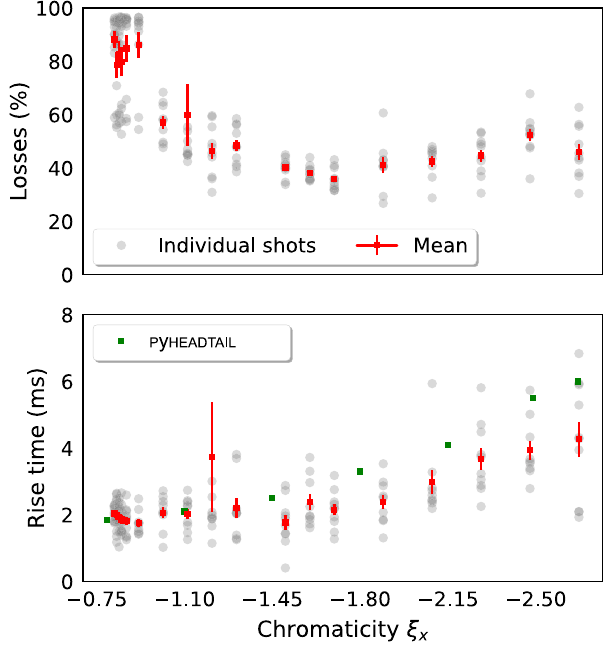
FIG. 5. Beam losses (upper plot) and instability rise time (bottom plot) versus horizontal chromaticity ξ x for Q x ¼ 4 . 28 and N ¼ 3 × 10 12 p. Individual shots per chromaticity setting are plotted in grey, while the mean values with their corresponding standard deviations are given in red. The losses decrease while the rise time increases as a function of chromaticity. The measured rise times are compared with P y HEADTAIL simulations (green) and found to be in reasonable